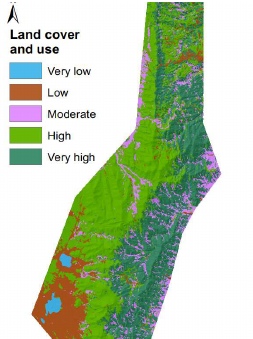
Figure 2. Weighted land use-land cover map